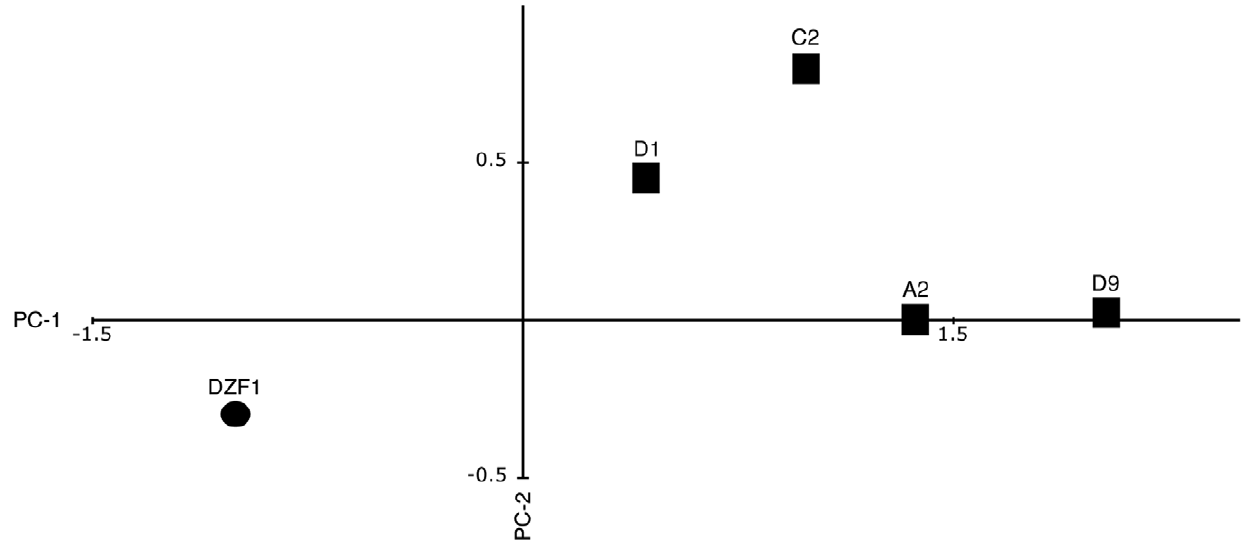
Figure 6. Principal Component Analysis of all strains. Traits included in the analysis are: log 10 terminal fruiting body count, log 10 terminal viability Count, log 10 terminal spore count, 36 hour development, coefficient of variation for fruiting body size at 72 hours, and fruiting body size at 72 hours, PC-1 and PC-2 account for 40% and 28.3% of the phenotypic variance, respectively.